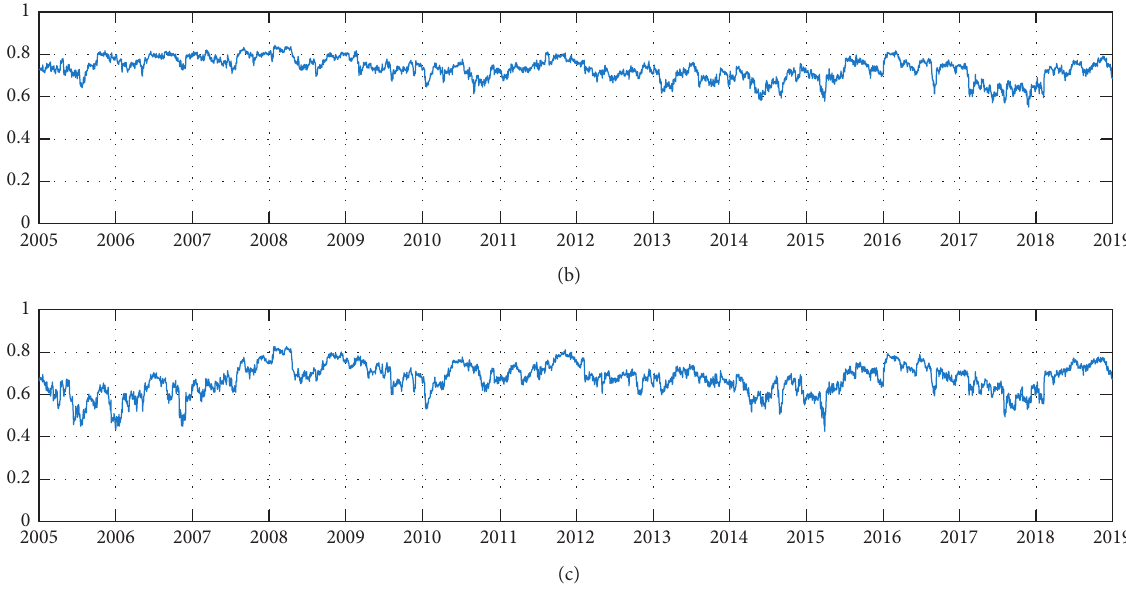
Figure 16: Kendall’s tau series of the bivariate DCC-NCCN copula model. (a) HSI-CEI. (b) HSI-CCI. (c) CEI-CCI.